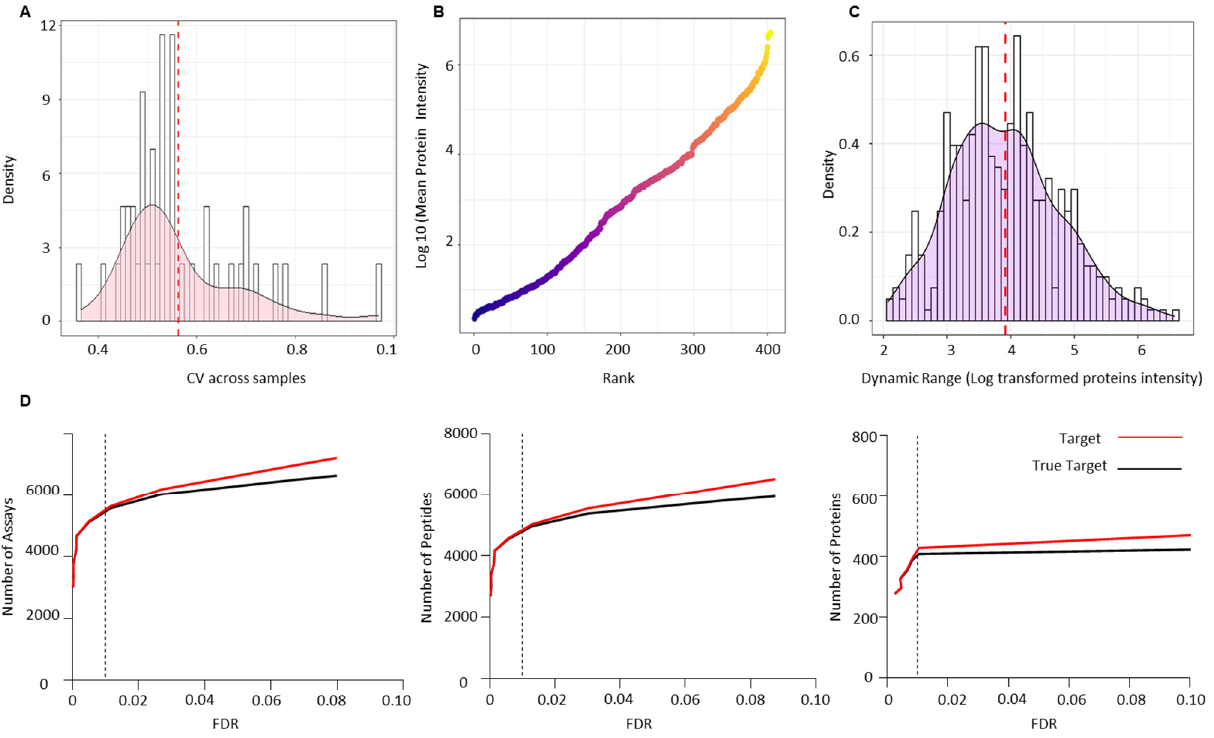
Figure 5. Technical validation of serum PCa spectral library using an independent PCa patient cohort of pre- ( n = 29) and post-radiotherapy ( n = 14) patients. ( A ) Coefficient of variance (CV) across all the validation samples. ( B ) Dynamic range of the PCa serum proteome based on the rank by abundance of the log10 mean intensity of all identified proteins in the validation cohort. ( C ) Dynamic ranges of individual proteins detected in the validation cohort based on the ratio of the maximum and minimum log10 protein intensities. ( D ) Number of transitions, peptides and proteins identified at 1% FDR across the validation cohort.